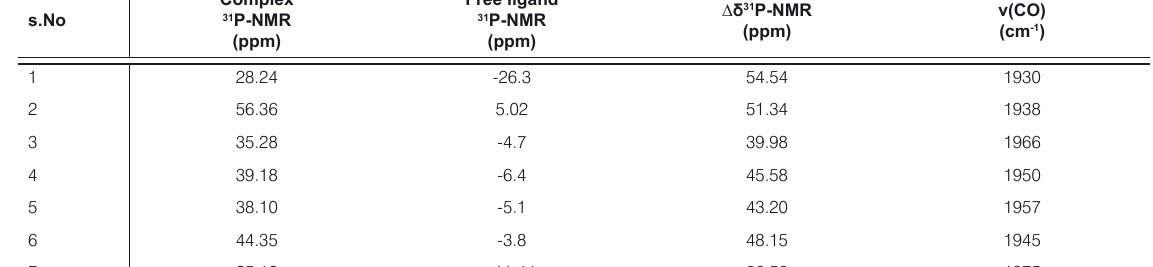
Table 1. Relationship between ∆ δ 31 P-NMR and ν (CO) of Rh(I)-phosphines. s.No